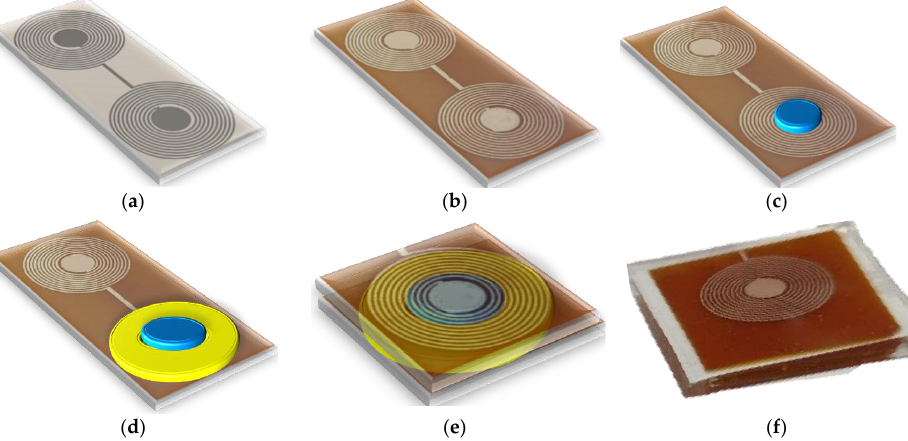
Figure 3. Step-by-step fabrication process: ( a ) Ink mask printed on copper-coated polyimide film. ( b ) Etched sensor patterns planar capacitor and inductor. ( c ) Circular PDMS layer as a dielectric layer on capacitor electrode. ( d ) Adhesive layer deposition. ( e ) PDMS encapsulated sensor. ( f ) Fab- ricated LC sensor. Table 1 . The key design parameters and electrical characteristics of the implanted sensor.